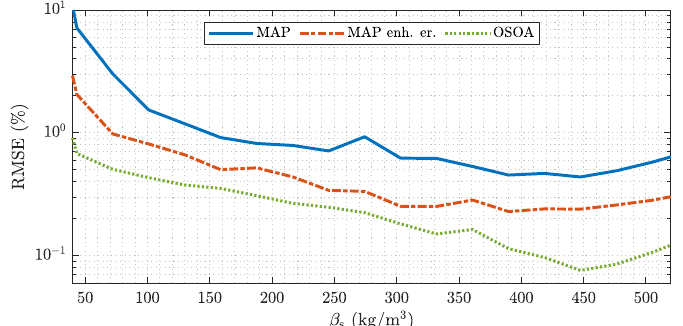
Figure 14. Model based analysis of the RMSE for ECT-based flow meters with different estimators. The analyses are performed over all flow regimes covered by the stochastic process